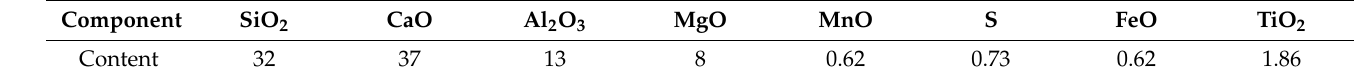
Table 1. Composition of the blast furnace slag (wt % ).